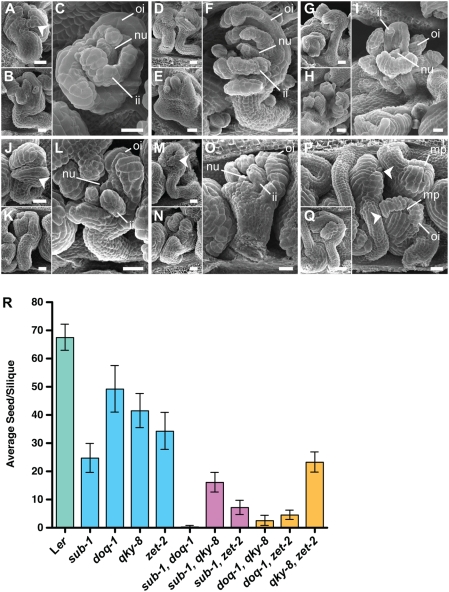
Comparison of ovule morphology in different slm double mutants.SEM micrographs of stage-4-V ovules are depicted. (A–C) sub-1 doq-1. (D–F) sub-1 qky-8. (G–I) sub-1 zet-2. (J–L) doq-1 qky-8. (M–O) doq-1 zet-2. (P,Q) qky-8 zet-2. Each double mutant shows a range of ovule phenotypes. (A, D, J, M and P) Mild phenotypes are depicted. Note the irregular size and shape of cells at the distal outer integument (arrow heads). (B, C, D, G K, N Q) Stronger ovule phenotypes are observed whereby specimens have half formed outer integuments. (C, F, I, L, O) In extreme cases, sub-1 doq-1, sub-1 qky-8, sub-1 zet-2, doq-1 qky-8 and doq-1 zet-2 ovules can show malformation of the inner integument. (C) This specimen is an example where the inner integument shows several gaps. (F, I, L, O) Inner integuments can also appear as finger-like protrusions. The qky-8 zet-2 double mutant is an exception, whereby inner integument defects are rarely observed. (E, H) Severely malformed ovules can also appear as integument-like and nucellus-like structures emerging from placental tissue. (R) Fertility was assayed as the average seed number per silique (n = 20). Abbreviations: fu, funiculus; ii, inner integument; mp, micropyle; oi, outer integument. Scale bars: 20 µm.